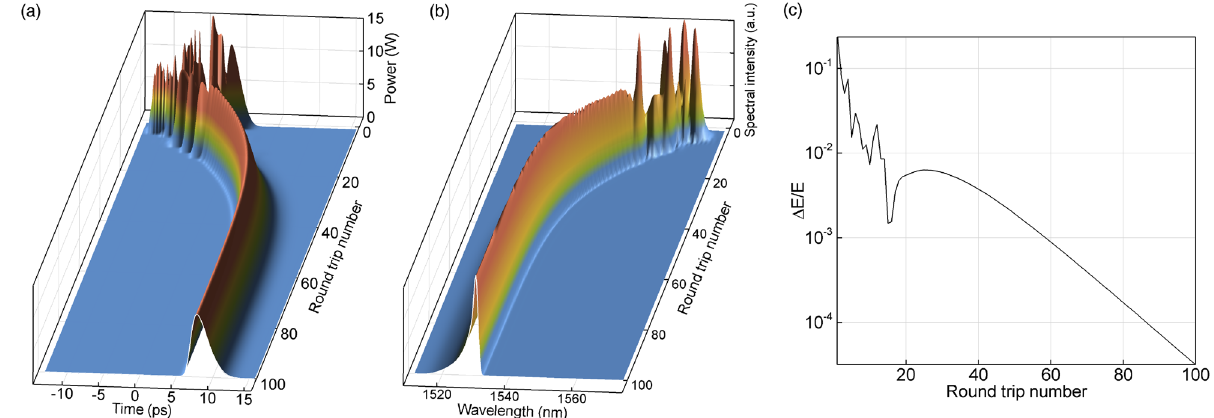
Figure 3. Evolution of pulse power ( a ) and power spectral density ( b ) with round trips in SOA-based fiber laser with 34 nm Gaussian filter. ( c ) Convergence of the output pulse energy variation to zero during the first 100 cavity round